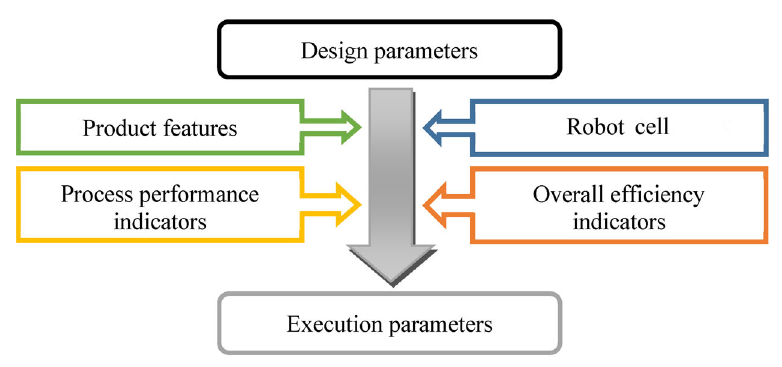
Fig. 1. Efficiency analysis of implementing robot cells in the companies.